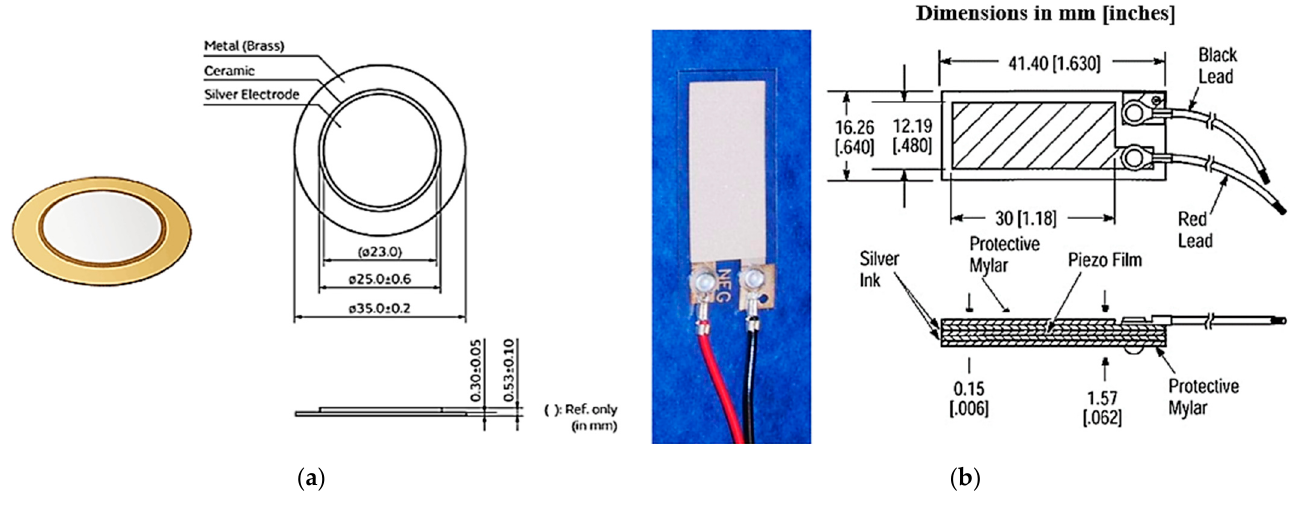
Figure 1. Acoustic emission sensors ( a ) PZT-7BB-35-3 and ( b ) MFC-LDT1-028K used in the